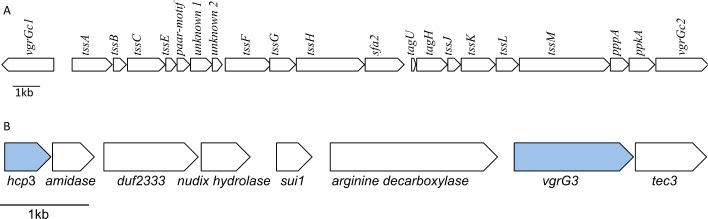
Genomic organisation of the T6SS core component locus and the hcp3 locus in MFE01.A. Genomic organisation of the T6SS core component locus in MFE01. Genes are represented as arrows, indicating the direction of transcription. The sequences of the T6SS core component genes have been deposited in GenBank under the following accession numbers: vgrGc1: KX941475, tssA: KX941476, tssB: KX941477, tssC: KX941478, tssE: KX941479, paar-motif: KX941480, unkown1: KX907122, unknown2: KX941481, tssF: KX941482, tssG: KX941483, tssH: KX941484, sfa2: KX941485, tagU: KX941486, tagH: KX941487, tssJ: KX941488, tssK: KX941489, tssL: KX941490, tssM: KX941491, pppA: KX941492, ppkA: KX941493, vgrGc2: KX941494. B. Genomic organisation of the hcp3 locus. Genes are represented as arrows, indicating the direction of transcription. The sequences of the hcp3 locus genes have been deposited in GenBank under the following accession numbers: hcp3: KX941495, vgrG3: KX941496, arginine-decarboxylase: KX941497, sui1: KX941498, nudix-hydrolase: KX941499, duf2333: KX941500, amidase: KX941501, tec3: KX941502.